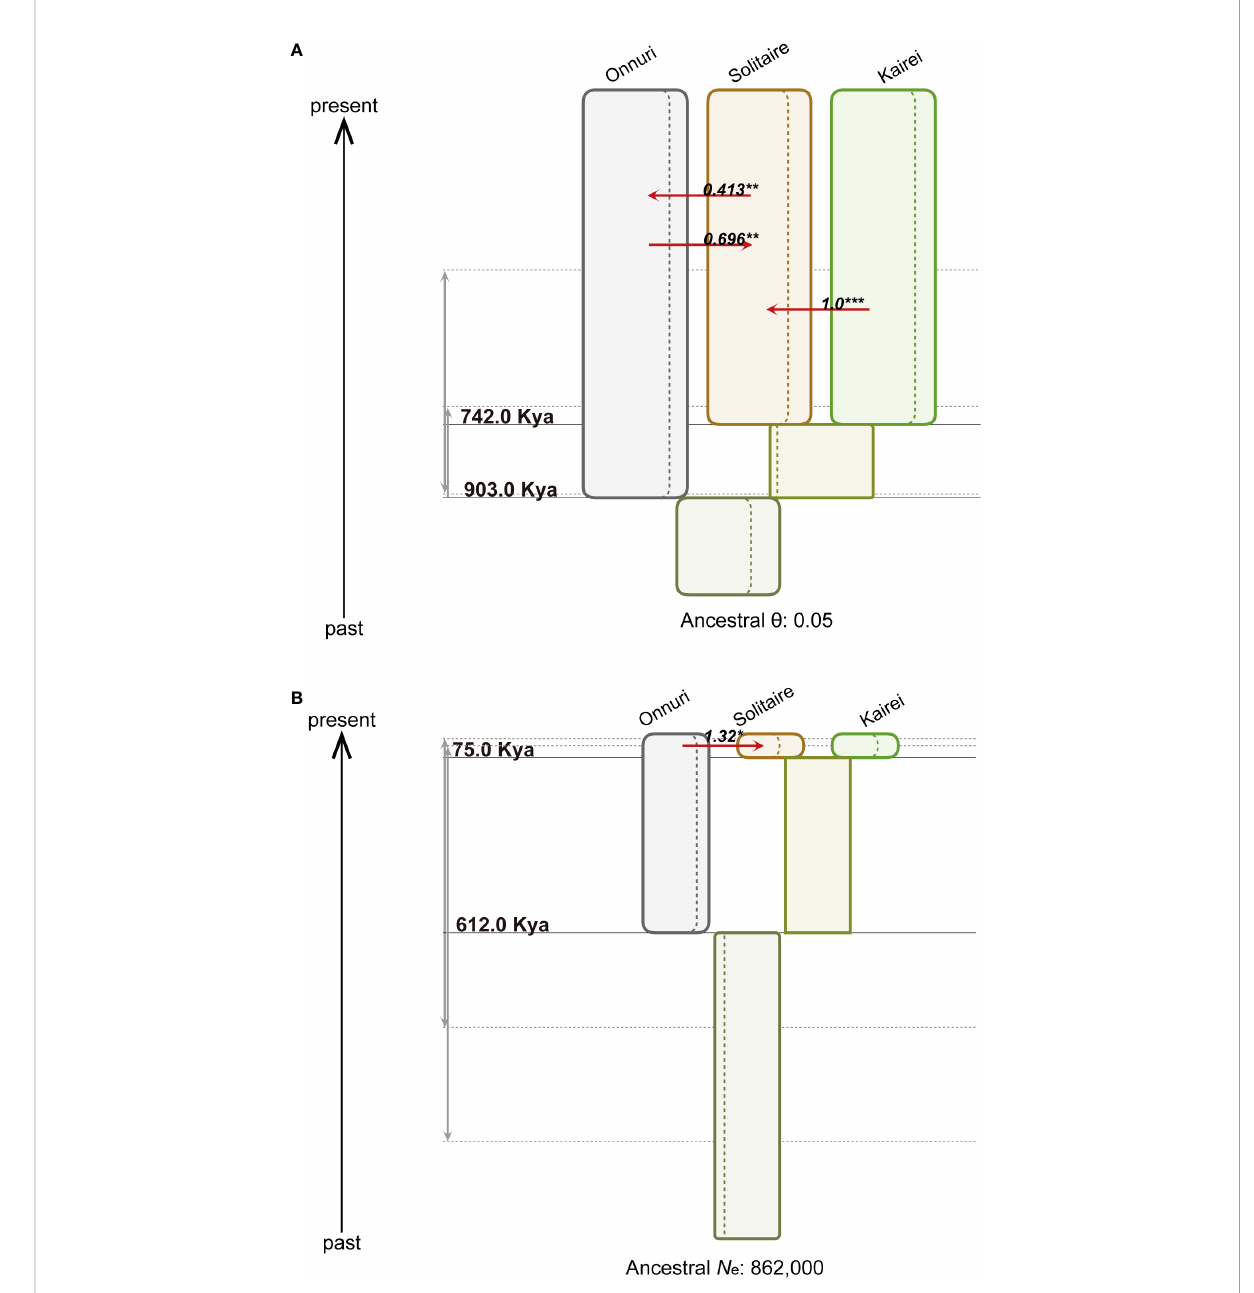
FIGURE 7 Demographic history of populations from three vent localities. The fi gures represent step 2 in Figure 2D. (A) Symbiotic bacteria. The width of the colored boxes is proportional to the maximum a posteriori estimates of the effective population size. The dashed lines within the boxes represent the 95% highest posterior density (HPD) intervals (Supplementary Table S10-12). The red arrow denotes the statistically signi fi cant population migration rate per generation ( Nm for symbiont and 2 Nm for host) using both marginal posterior distribution (* a = 0.05, ** a = 0.01, *** a = 0.001). The gray arrows represent 95% HPD intervals of each splitting time. For the symbiotic bacteria, the effective population size was scaled by mutation rate ( q ) due to the uncertainty of the generation time of mussel symbiotic bacteria. (B) Host mussels. The fi gure description is the same as that for (A) . The effective population size of hosts ( N e ) was estimated assuming a generation time of one